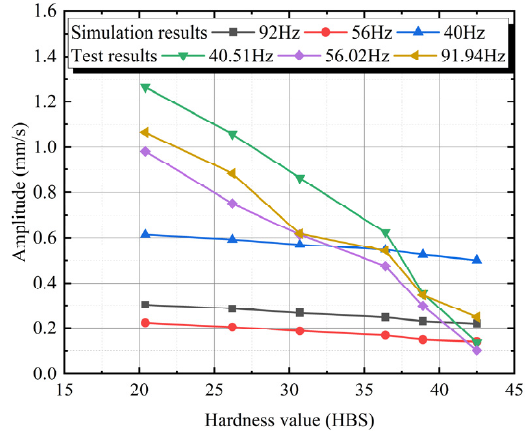
Figure 20. Hardness affects axial vibration .